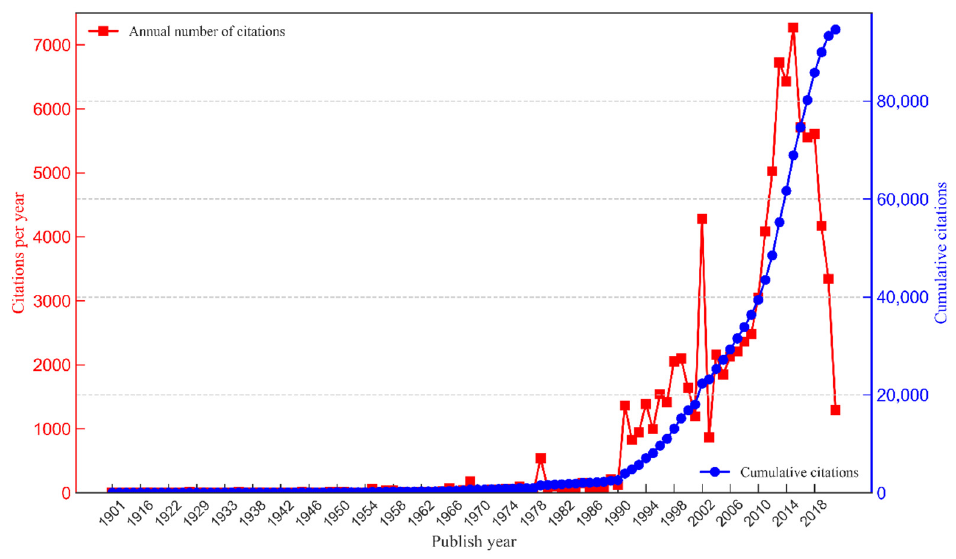
Figure 3. Cumulative and annual number of citations attracted by literature in oil and gas wells from 1900 to 2021.